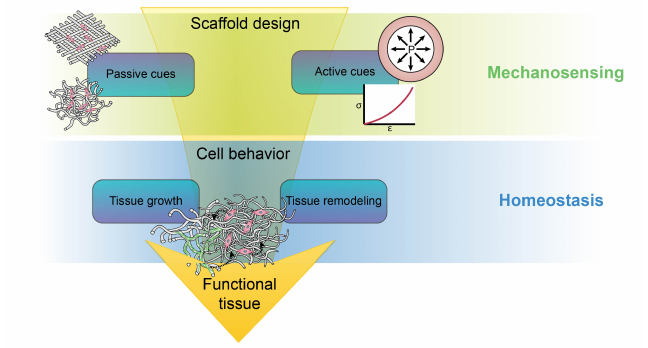
Figure 5. A rational design of a scaffold should provide the right passive cues and transmit the right active cues to guide cells towards a mechanical homeostasis via growth and remodeling. The process of growth and remodeling is both active (cell-mediated) and passive (e.g., dilatation of the vessel wall and micro-structure dictated by degree of axial pre-stress). Following this approach results in controlled in situ